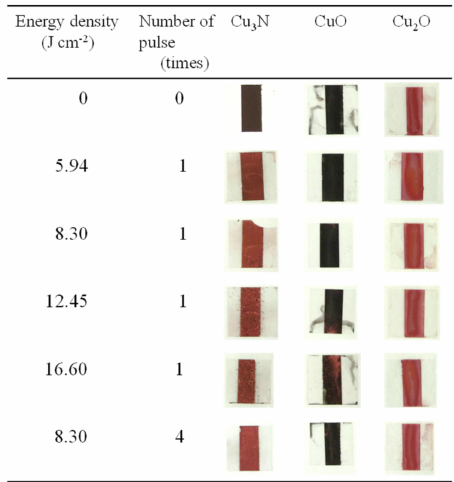
Figure 7. Appearance of films prepared with vehicle 2 and containing (Cu 3 N), copper(I) oxide (Cu 2 O), or copper(II) oxide (CuO) before and after intense pulsed light irradiation under the conditions shown in Table